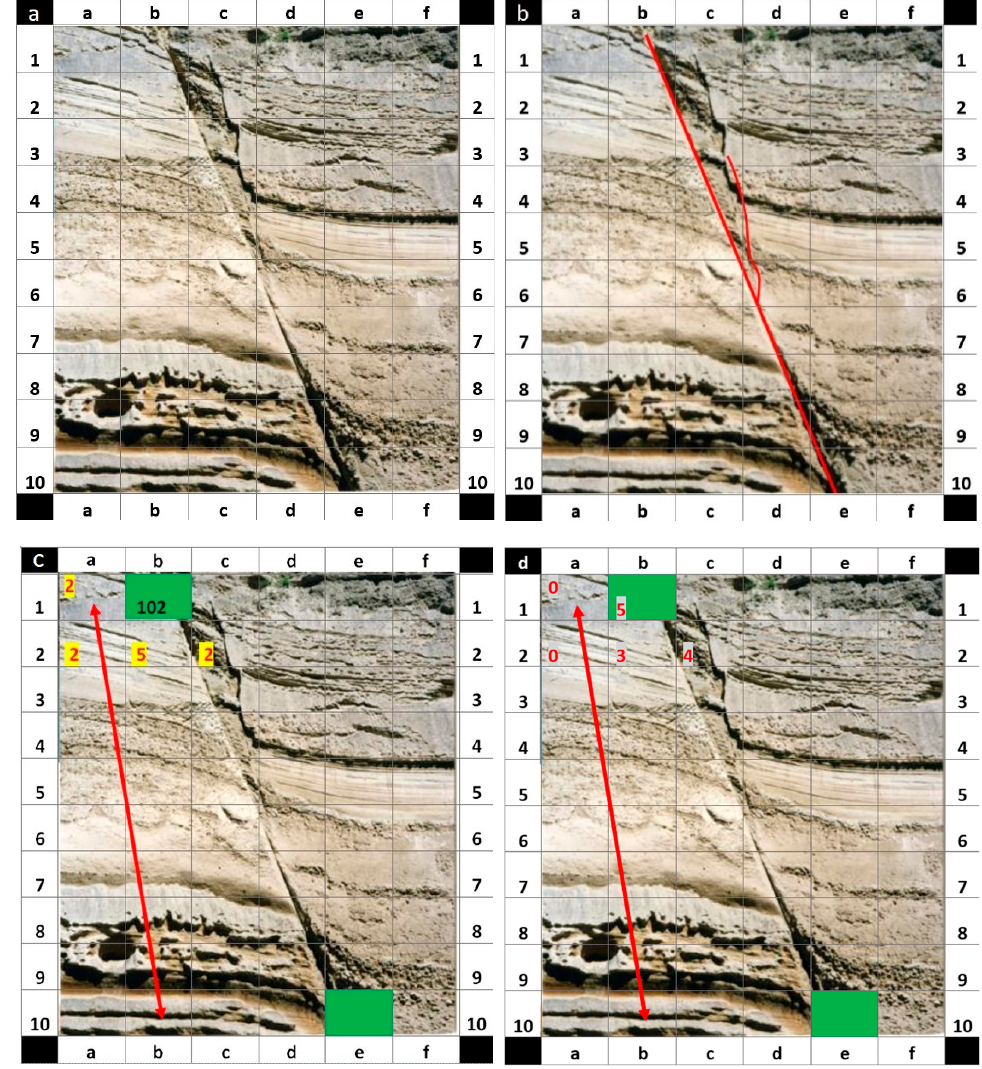
Figure 4. ( a ) Exercise 1 of the questionnaire. The photo shows a fault plane that offsets sediments in the Corinth Canal, Greece. The fault deforms the sediments to a normal drag fold since the almost horizontal sedimentary succession is warped in the transport direction of the fault. ( b ) The red line highlights the initial and end point of the fault in the outcrop. The correct answer is b1–e10 or e10–b1. These answers corresponded to 5 marks. ( c ) Summary of the answers given numerically by the students. ( d ) Answers as given by the students as marked from 1 to 5.